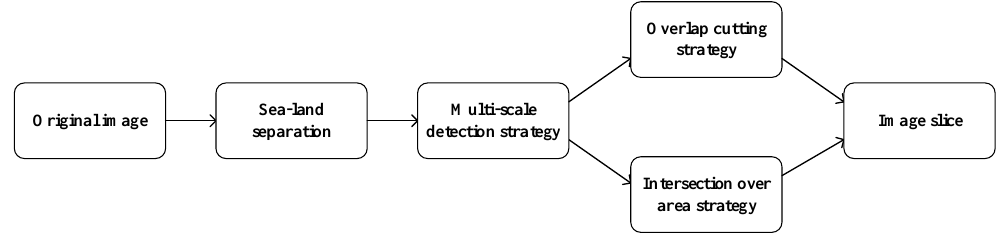
Figure 1. Flow diagram of the overall detection